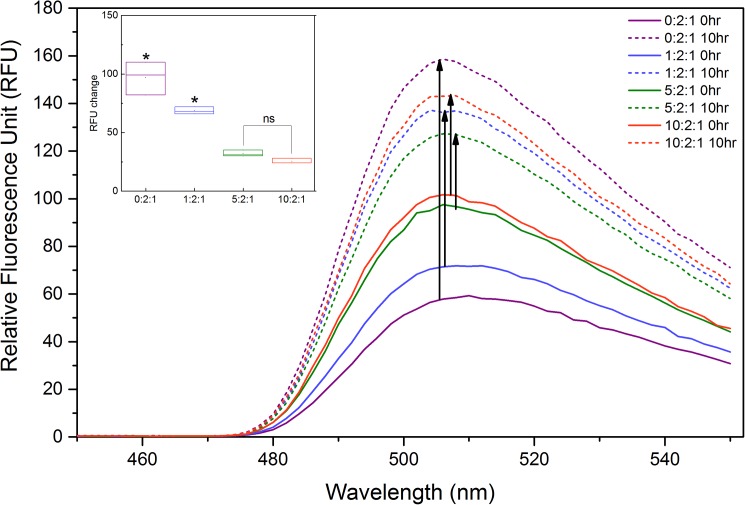
ThT fluorescence emission spectra of crystallin proteins in 0:2:1, 1:2:1, 5:2:1 and 10:2:1 ratios incubated at room temperature for 10 hours (solid lines) and exposed to UV-B radiation for 10 hours (dotted lines).Inset graph represents the relative intensity difference between UV-B treated and untreated samples. The data represents the average of 3 independent experiments and error bars represent SD. *: P<0.01, ns: Not Significant.